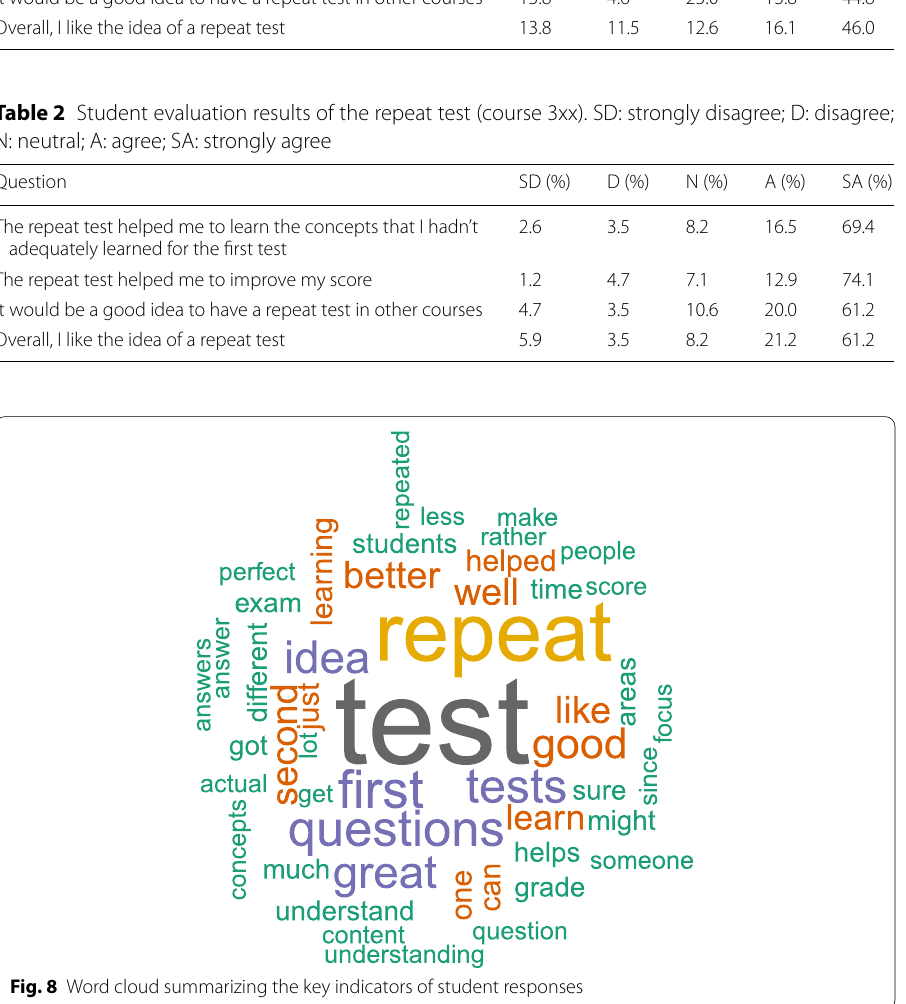
Fig. 8 Word cloud summarizing the key indicators of student